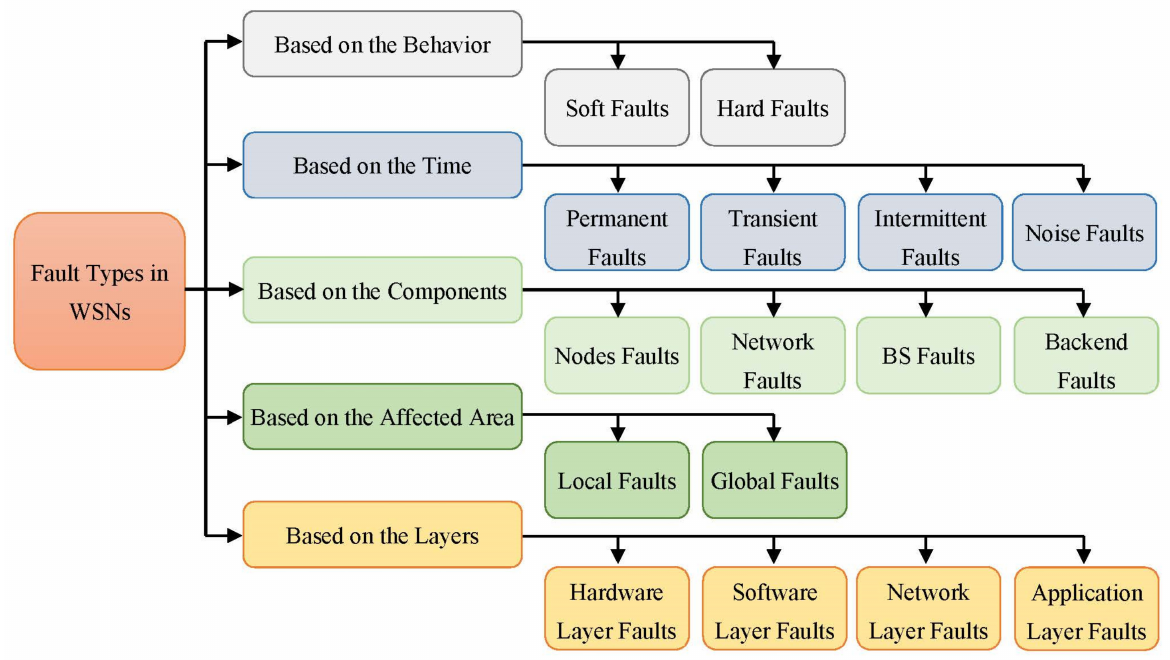
Figure 1. A taxonomy for the different fault types in